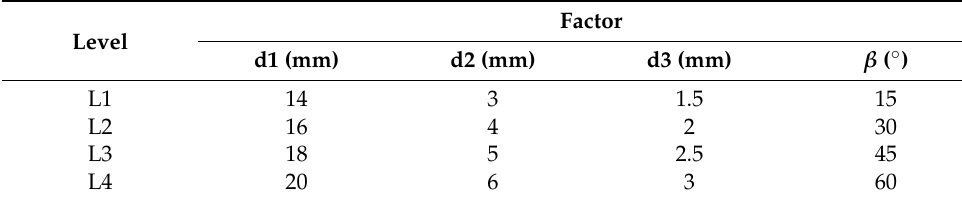
Table 3. Experimental factors and